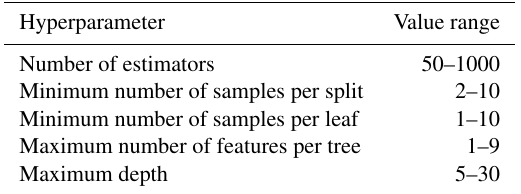
Table 4. Hyperparameter input range for model